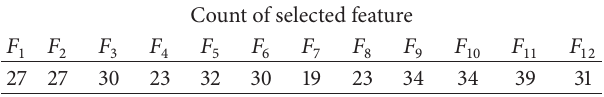
Table7:Countofselectedfeaturebyusing10-foldcross-validations. Count of selected